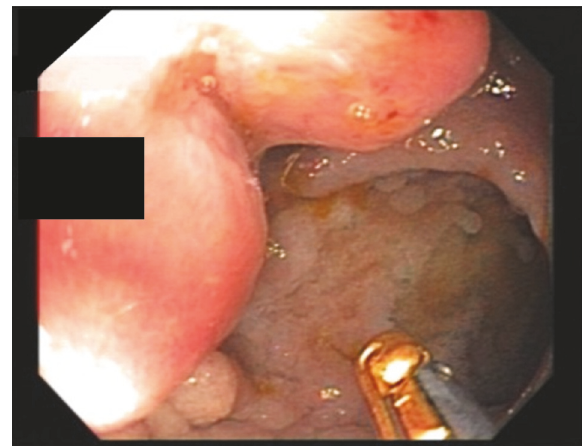
Figure 1: Endoscopic image of ulcerated polypoid lesion discovered in the terminal ileum during routine screening colonoscopy.